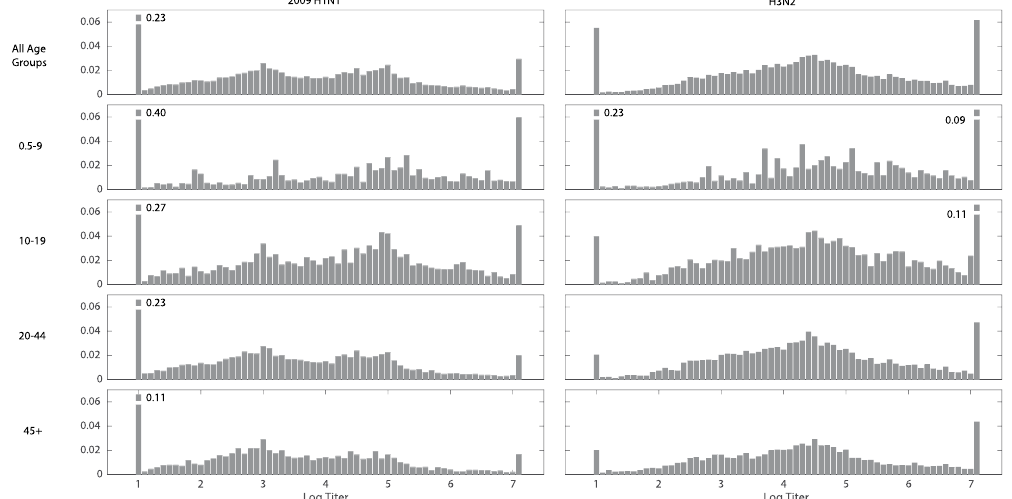
Figure 1. Antibody titer histograms for n = 20,152 individuals, plotted for all ages (top panels) and by age group (bottom four panels). Titers shown are to the HA1 components of the 2009 H1N1 pandemic influenza virus (left column) and to recently circulating H3N2 viruses (right column). The fractions of individuals with titers below the detection limit of 20 and above 1280 that were out of the plotting ranges are given next to the respective bar. Histograms were weighted to adjust for age and gender according to the Vietnam national housing census in 2009 for the four collection